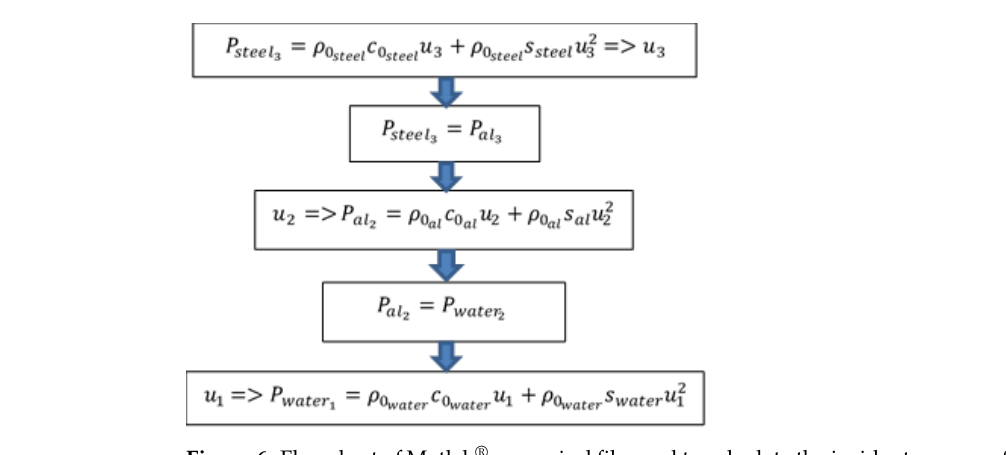
Figure 6. Flowchart of Matlab ® numerical file used to calculate the incident pressure from transmitted pressure to steel using 1D shock theory.